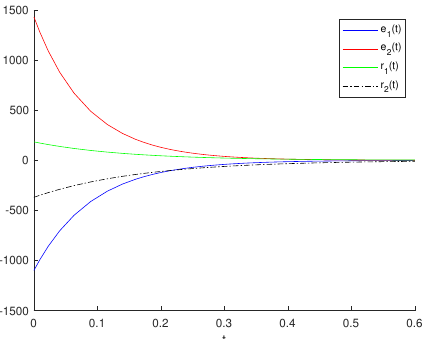
Figure 6. The curves of e 1 ( t ) , e 2 ( t ) , r 1 ( t ) , r 2 ( t ) from Example